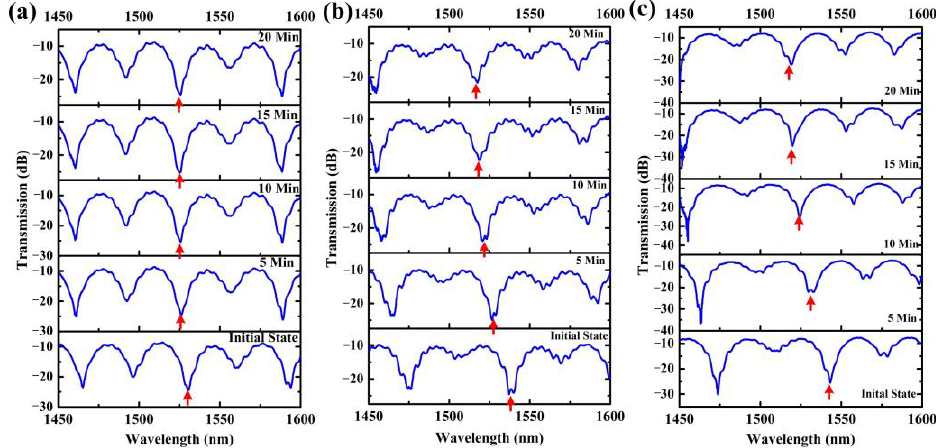
Figure 4. Transmission spectra evolution of the proposed sensor with 3.0 µ m diameter at ( a ) 30 ◦ C, ( b ) 50 ◦ C and ( c ) 70 ◦ C, the duration time of heating was 20 min in the experiment. The red arrows in the spectral responses represent corresponding dip wavelength shifts as elapsed time increases.